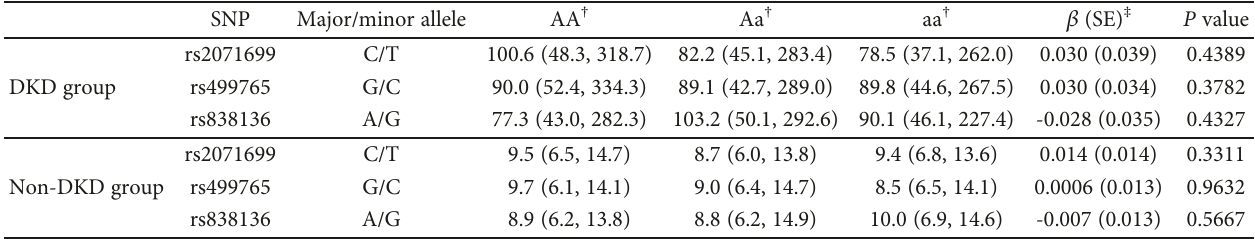
Table 6: Associations between the SNPs and AER (mg/24 h) in the study